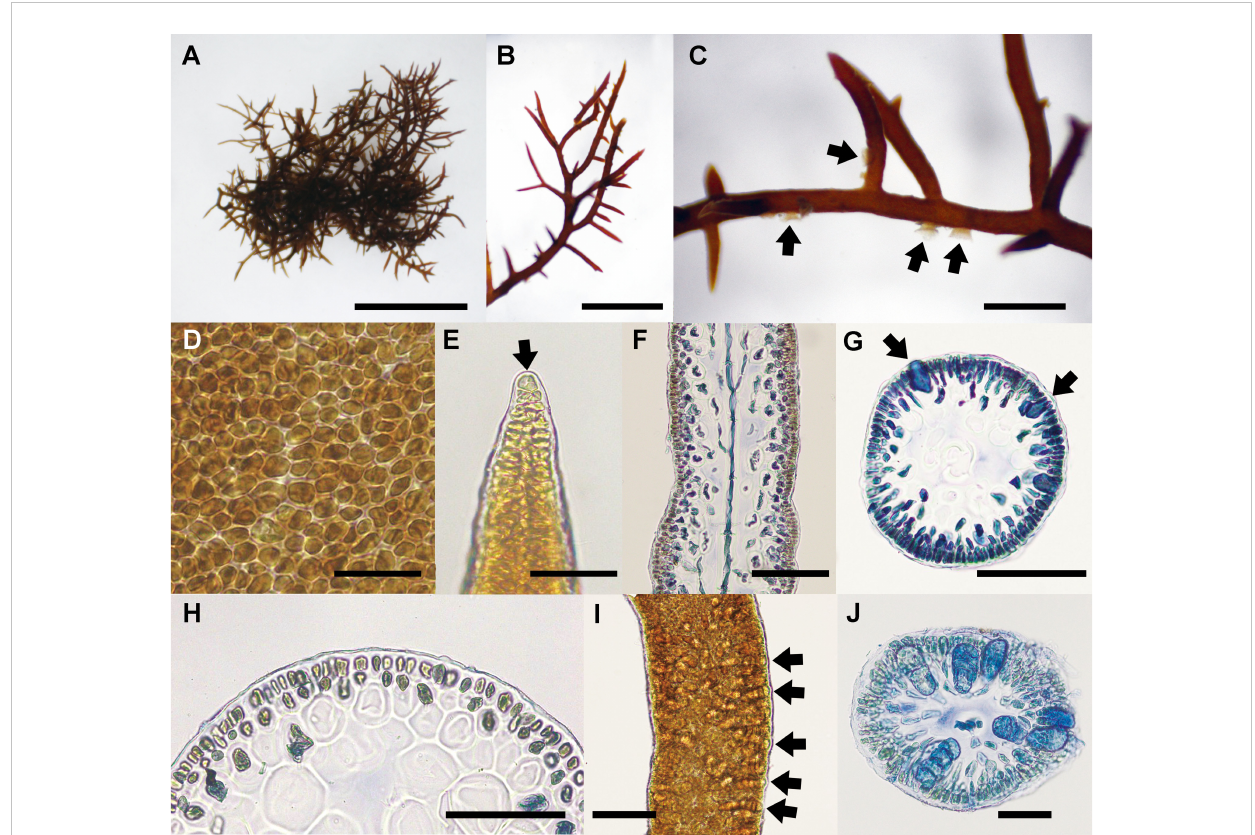
FIGURE 6 Caulacanthus ustulatus from Ca ́ diz, Spain. (A) Habit of thallus collected at San Sebastian, Ca ́ diz, on April 28, 2014. Scale bar = 300 m m. (B) Apical part of branches with numerous short branchlets. Scale bar = 200 m m. (C) Several projections (arrows) on a branch. Scale bar = 100 m m. (D) Surface view of a thallus showing circular to polygonal cortical cells. Scale bar = 30 m m. (E) Apical cell (arrow) of a thallus tip. Scale bar = 50 m m. (F) Longitudinal section of a thallus median part showing an axial fi lament. Scale bar = 100 m m. (G) Cross section of distal portion of tetrasporophytic thallus showing immature tetrasporangia (arrows). Scale bar = 100 m m. (H) Layer of ovoid cortical cells. Scale bar = 30 m m. (I) Tetrasporangia of a branchlet. Scale bar = 50 m m. (J) Zonately divided tetrasporangia (arrows) in the cortex. Scale bar = 50 m